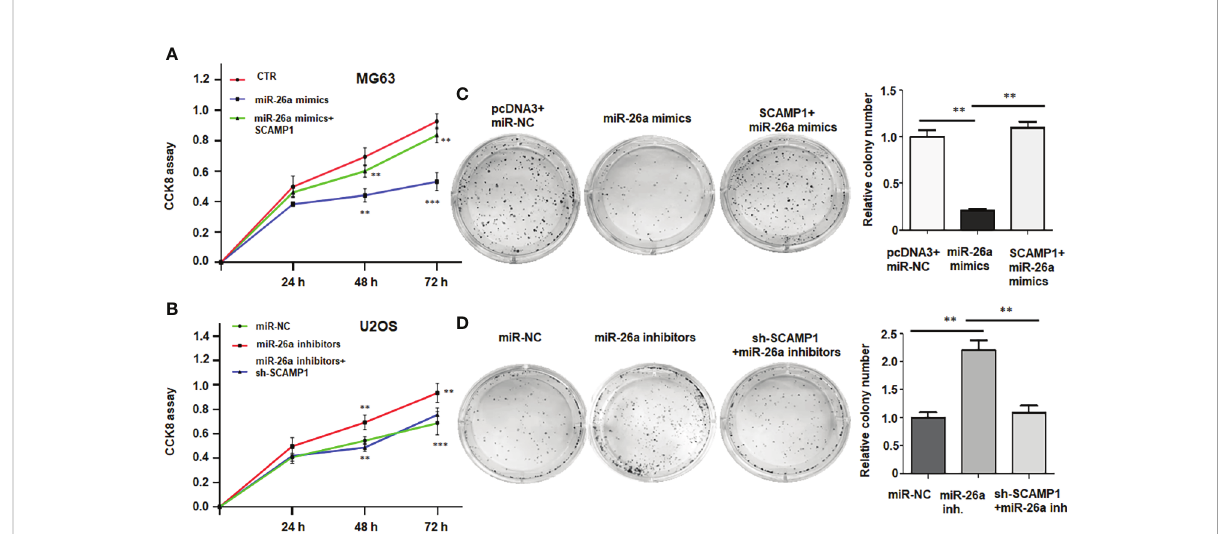
FIGURE 5 LncRNA SCAMP1 overexpression promotes cell viability and colony formation via miR-26a-5p. (A) : CCK8 assays showed that overexpression of lncRNA SCAMP1 abolished miR-26a-5p mimics-mediated inhibition of cell viability in MG63 cells. (B) : CCK8 assays showed that inhibition of miR-26a-5p enhanced viability of U2OS cells, which was abrogated by shR-SCAMP1 transfection. (C) : Left panel: Colony formation assays showed that in SCAMP1-overexpressing MG63 cells, miR-26a-5p mimics-mediated suppression of colony formation was abolished in MG63 cells. Right panel: quantitative data is shown for colony formation of MG63 cells. (D) : Left panel: Colony formation assays showed that in U2OS cells with shR-SCAMP1 transfection, miR-26a-5p-inhibitor-induced colony formation was blocked. Right panel: quantitative data is shown for colony formation of U2OS cells. miR-26a inh: miR-26a inhibitors. **p<0.01; ***p<0.001 vs. control